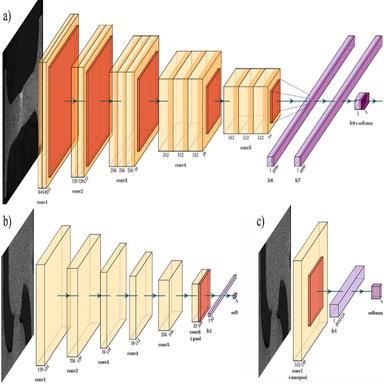
VGG16 network architecture containing a total of 5 convolutional and two feed-forward parts (a). Examples of different CNN architectures with large and restricted (b) as well as restricted and large (c) convolutional and feed-forward parts, respectively, for the identification of surface cracks in fracture experiments.